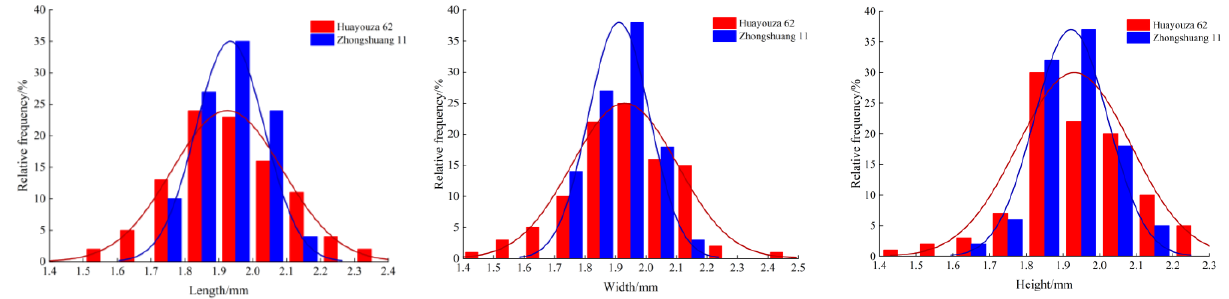
Figure 7. Triaxial size frequency distribution histogram of rapeseed seeds.